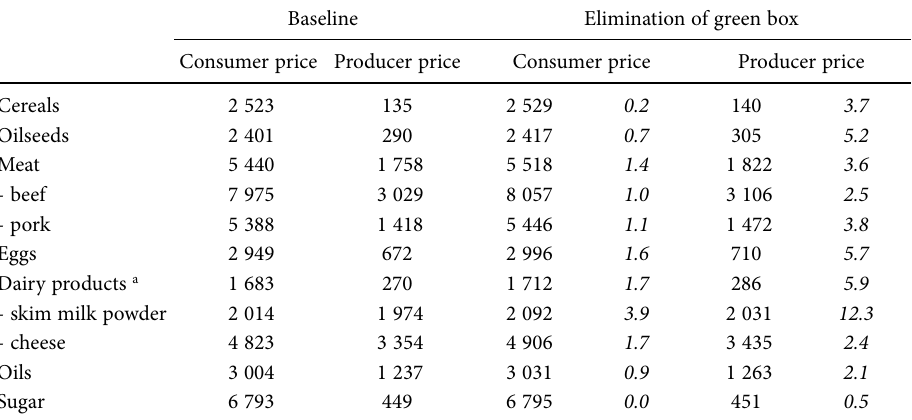
Table 4. Commodity prices for the EU in 2020 by type of scenario (Euro per ton, percentage change compared to baseline in